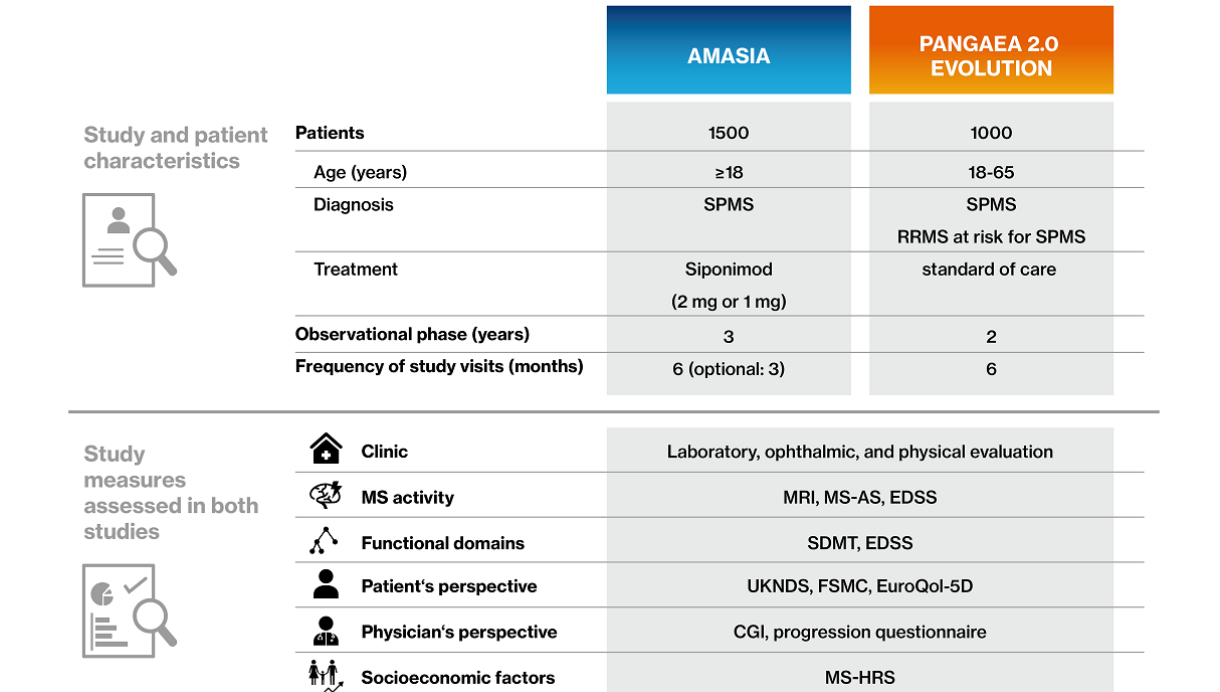
Figure 4. Pairwise comparison of data obtained during AMASIA (imp A ct of M ayzent [siponimod] on second A ry progressive multiple S clerosis patients in a long-term non- I nterventional study in Germ A ny) and PANGAEA 2.0 EVOLUTION, including study design, patient characteristics, and concordant and additional measures of multiple sclerosis (MS) activity, disability progression, functional domains, quality of life, and socioeconomic factors. Standard of care includes current disease-modifying therapy or no treatment at inclusion. CGI: clinical global impression; EDSS: Expanded Disability Status Scale; FSMC: Fatigue Scale For Motor And Cognitive Functions; MRI: magnetic resonance imaging; MS-AS: MS activity scale score; MS-HRS: Multiple Sclerosis Health Resource Utilization Survey; RRMS: relapsing remitting multiple sclerosis; SDMT: Symbol Digit Modalities Test; SPMS: secondary progressive multiple sclerosis; UKNDS: United Kingdom Neurological Disability